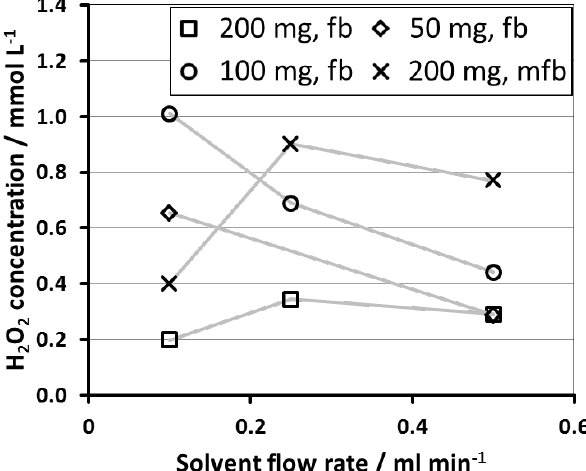
Figure 2. Hydrogen peroxide concentration over solvent flow rate for varying catalyst masses and catalyst arrangements using a 0.5 mm deep micro channel and a 180 μm Nafion ® membrane at 10 bars system pressure with water with additives as solvent: squares: 200 mg Pd/TiO 2 in a PVC-tube